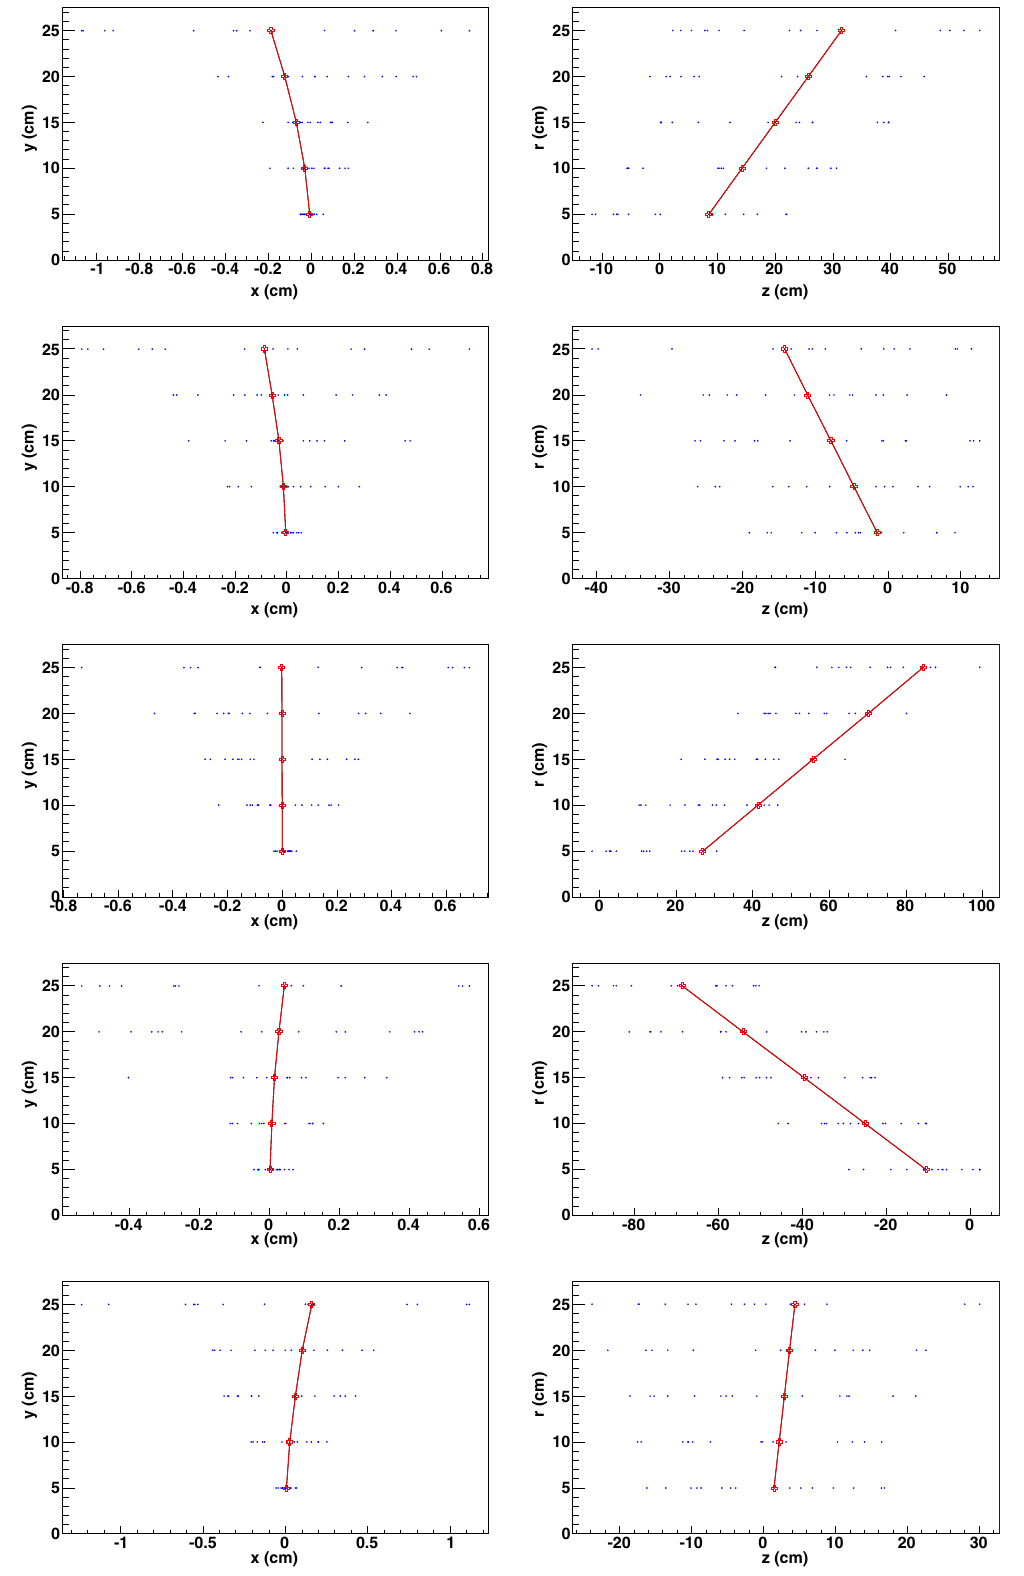
Figure 11. Five examples of events showing the high- p T signal track (red curve) found amongst the pileup hits (blue dots) in the transverse (left) and longitudinal (right) views. The red points denote hits created by the signal